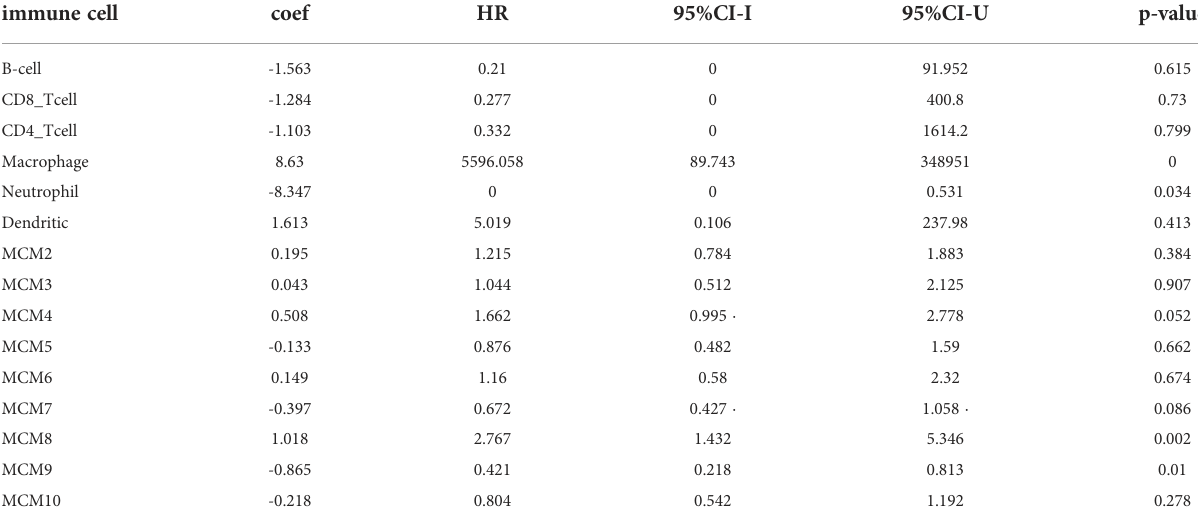
TABLE 2 The Cox proportional hazard model of the MCMs family and six tumor-in fi ltrating immune cells in glioma. immune cell coef HR